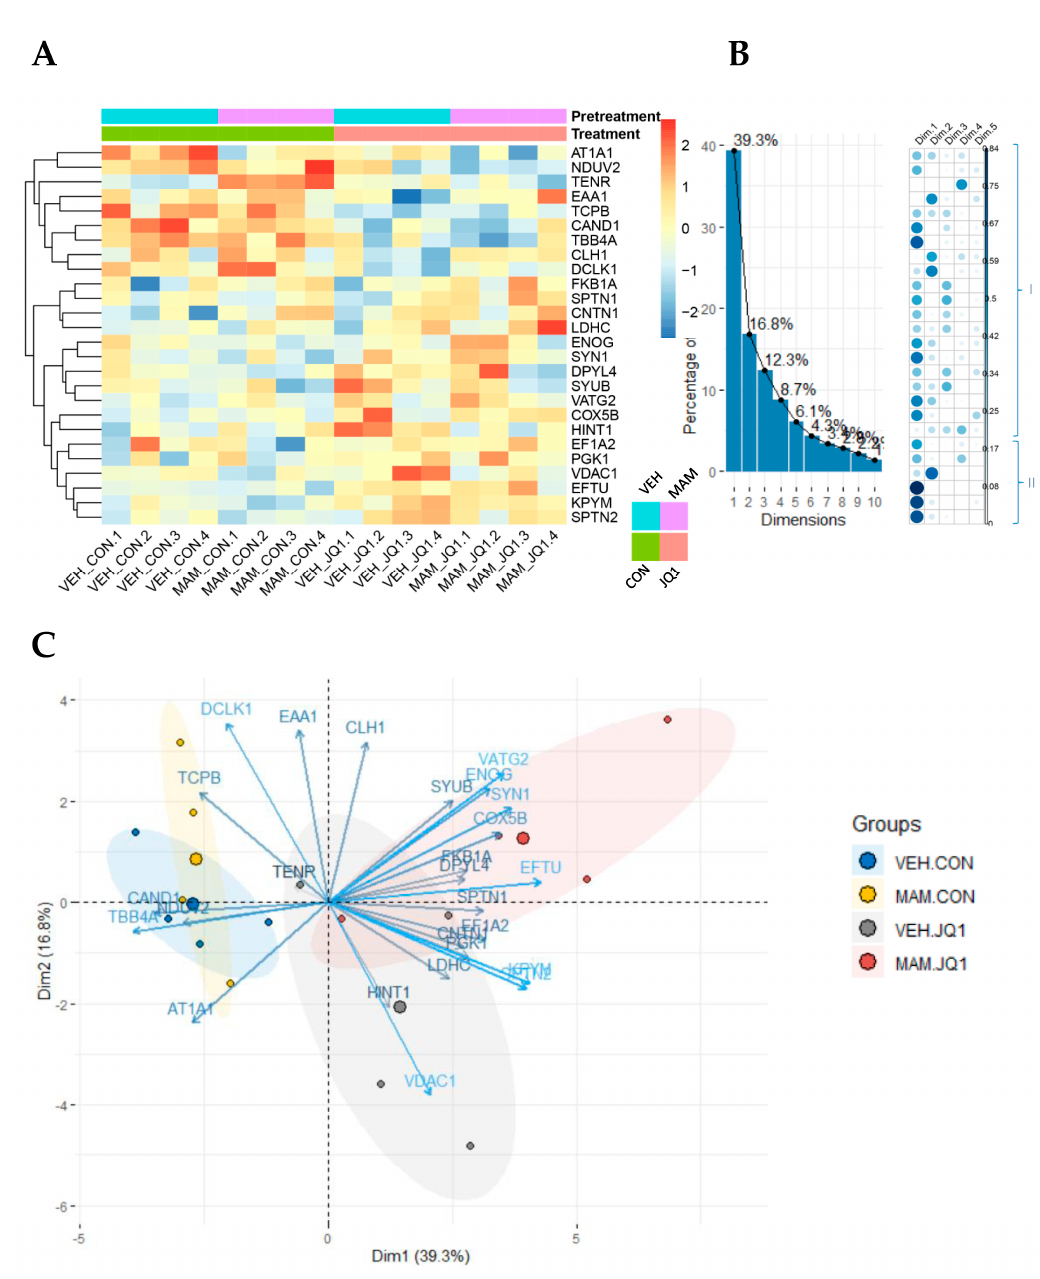
Figure 10. Proteomics study in the adult medial prefrontal cortex of females in the MAM-E17 model of schizophrenia. The rats were exposed to JQ1 or vehicle (CON) in early adolescence (P23–P29), and the analyses were performed in rats at P110. ( A ) Heatmap view of 26 differentially expressed proteins across groups ( p textless 0.050) identified from iTRAQ analysis. The colour scale illustrates the relative expression level of each protein across the 4 samples (biological replicates of mPFC) of each group: VEH-CON (1–4), MAM-CON (1–4), VEH-JQ1 (1–4), and MAM-JQ1 (1–4). Red and blue indicate higher and lower expression than the median expression value, respectively. The colour palette (right bar) represents standardised protein expression values (from red: upregulated, to blue: downregulated proteins). ( B ) Correlogram of the representation of the differentially expressed proteins depicted in the heatmap as well as their contribution to the principal components (Dim1–Dim5). Protein clusters (I–II) on the right correspond to proteins visualised on the heatmap and correlogram. ( C ) PC biplot of the differentially expressed proteins. On the whole, both components are linked to clusters (I and II) affected by adolescent JQ1 treatment. The first two principal components enabled us to visualise proteins engaged in JQ1 treatment. Abbreviated protein names are defined in Table